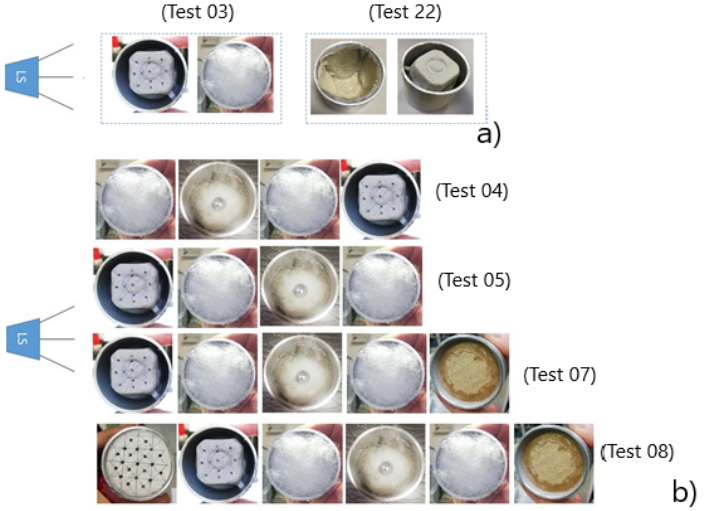
Figure 7. Configurations analyzed with the impedance tube: ( a ) samples made of egg- boxes and polyester, and ( b ) samples made of egg-box, polyester and a metallic element. Samples 04 and 05 are made of the same elements but in sample 04 the polyester faces the loudspeaker. Sample 08 has an additional perforated cardboard layer.